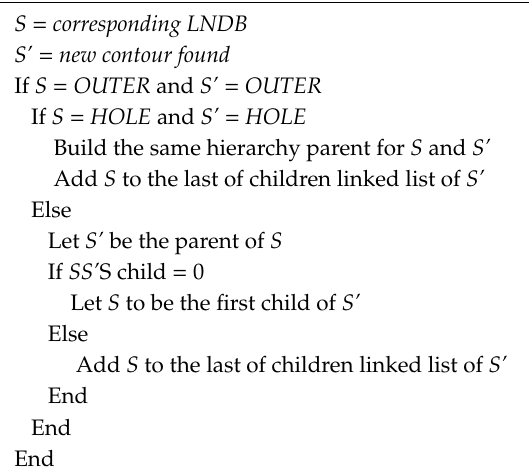
Algorithm 1: Build Contour